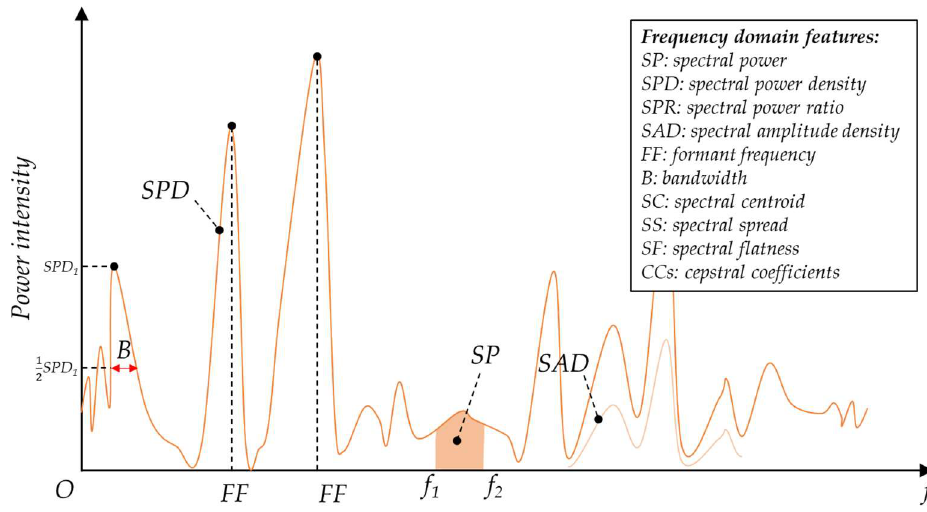
Figure 6. Frequency domain features.